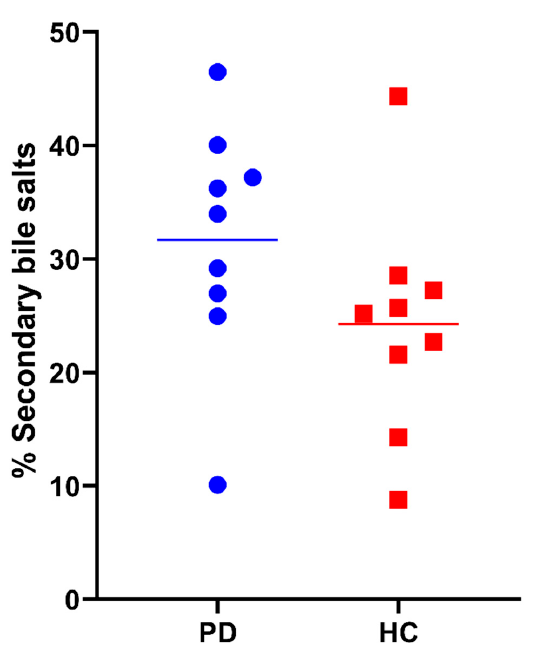
Figure 11. Percentage of secondary bile salts (i.e., GDC, TDC, DC, GUDC, TUDC, UDC and LC) in duodenal fluids aspirated from Parkinson’s disease patients (PD, blue circles) and healthy controls (HC, red squares). Data points represent the mean per subject; lines depict the overall average per study population.